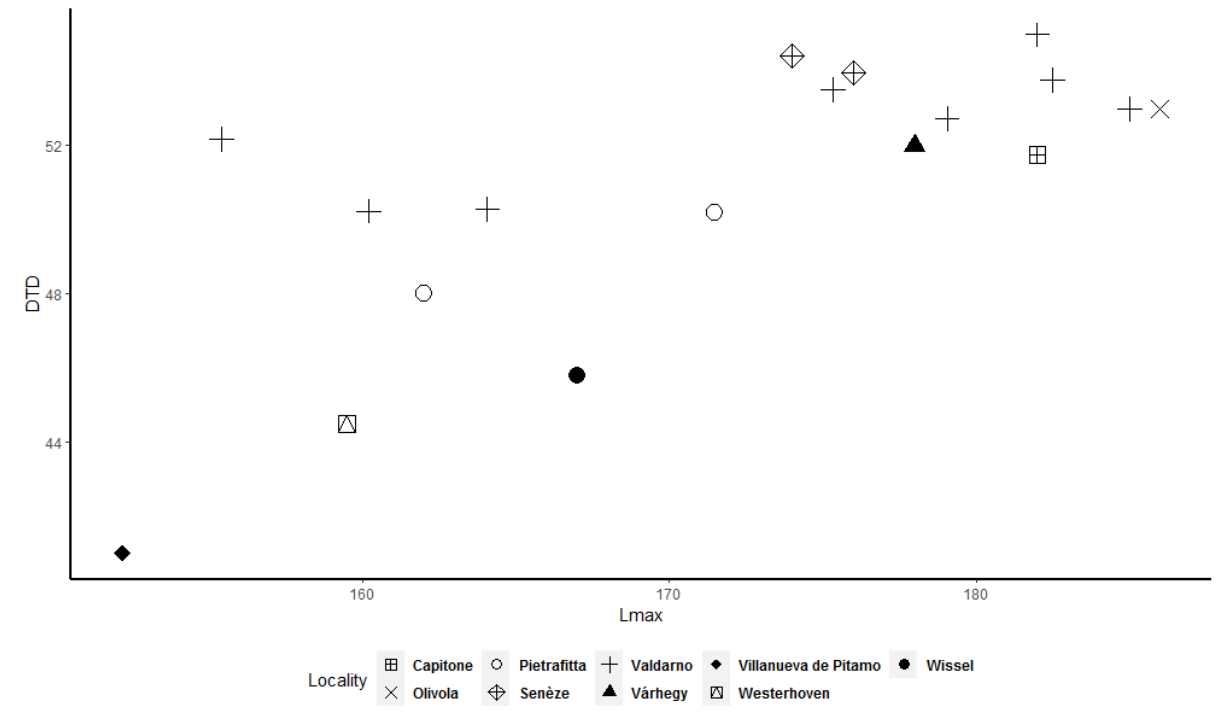
Figure 12. Scatterplot between the maximum length (Lmax) and the distal transverse diameter (DTD) of the MTIII.